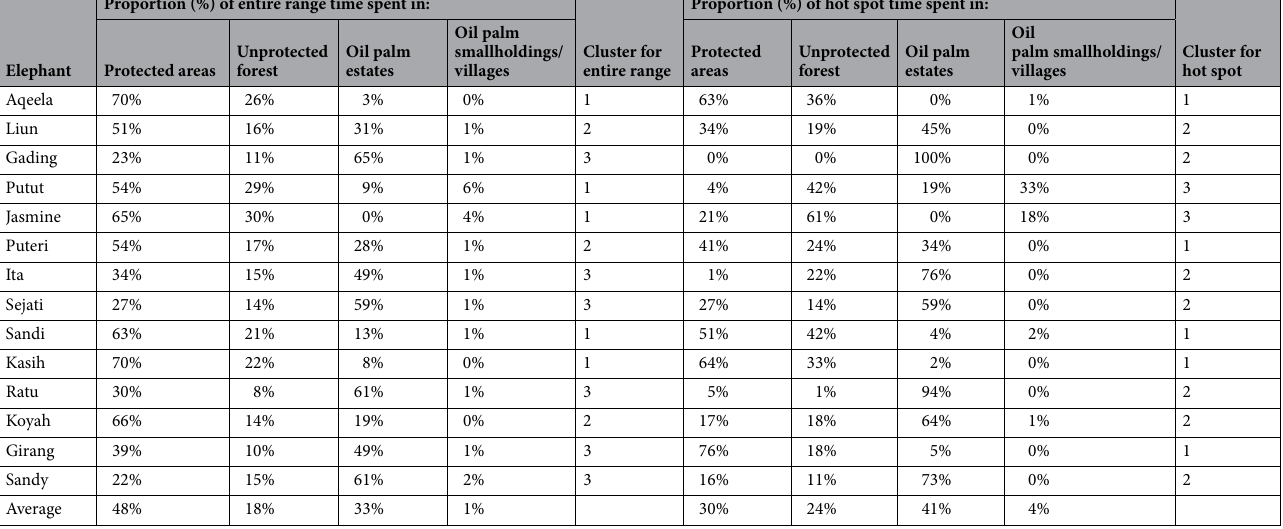
Table 5. Percentage of time spent within four land use/land cover categories for the entire range and hot spots analyses, and cluster category from the k-means clustering.